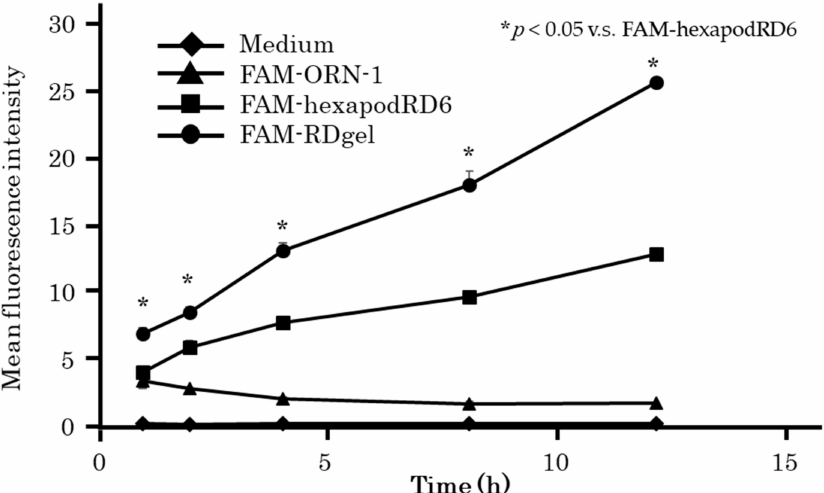
Figure 6. Uptake of ORN-1-FAM, FAM-hexapodRD6, and FAM-RDgel by DC2.4 cells. The mean fluorescence intensity of DC2.4 cells after addition of FAM-ORN-1, FAM-hexapodRD6, or FAM-RDgel was measured by flow cytometry. The results are expressed as mean ± SD of three independent experiments, * p < 0.05 compared with